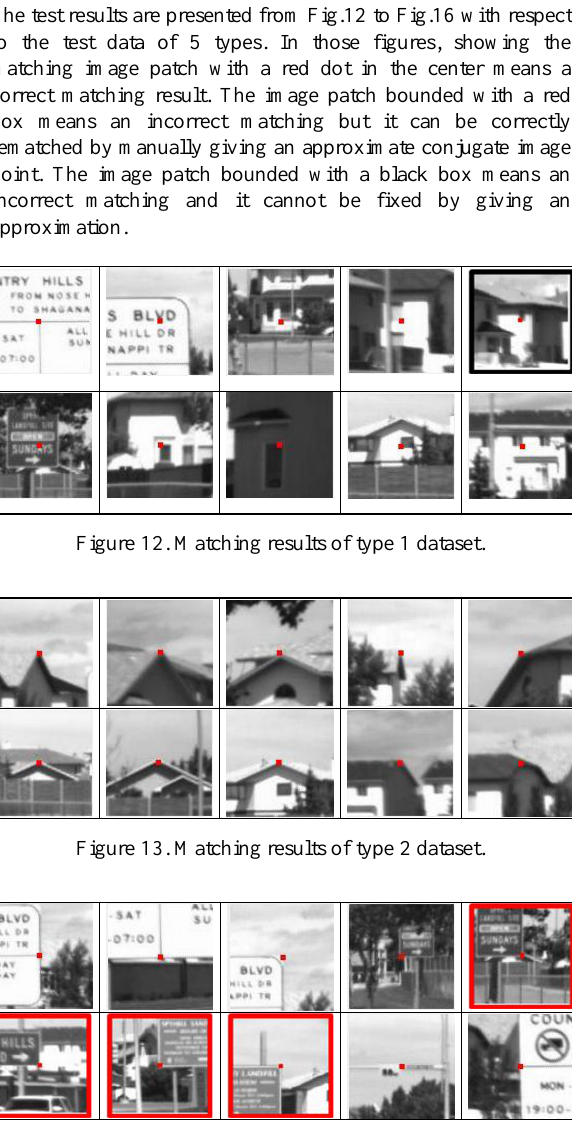
Figure 14. Matching results of type 3